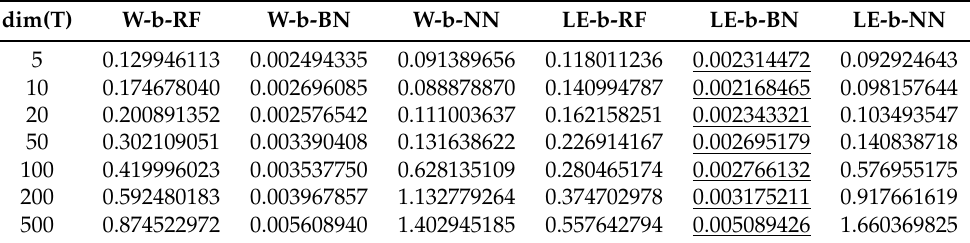
Table 9. Computational time of the anomaly detection with different dimensions.